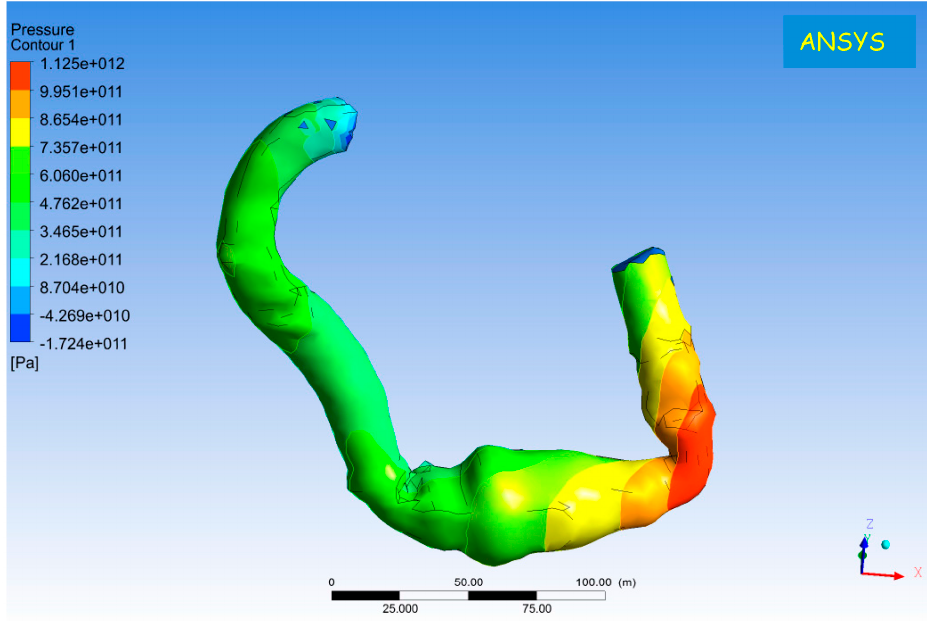
Figure 2. 3D reconstruction from CT-scan of HeartMate II following prolonged circulatory support. Simulation with k- ω SST (shear stress transport) model: mass flow inlet, 0.1 kg/s; pressure outlet, 100 mmHg; rotational speed ω = 9200 rpm.